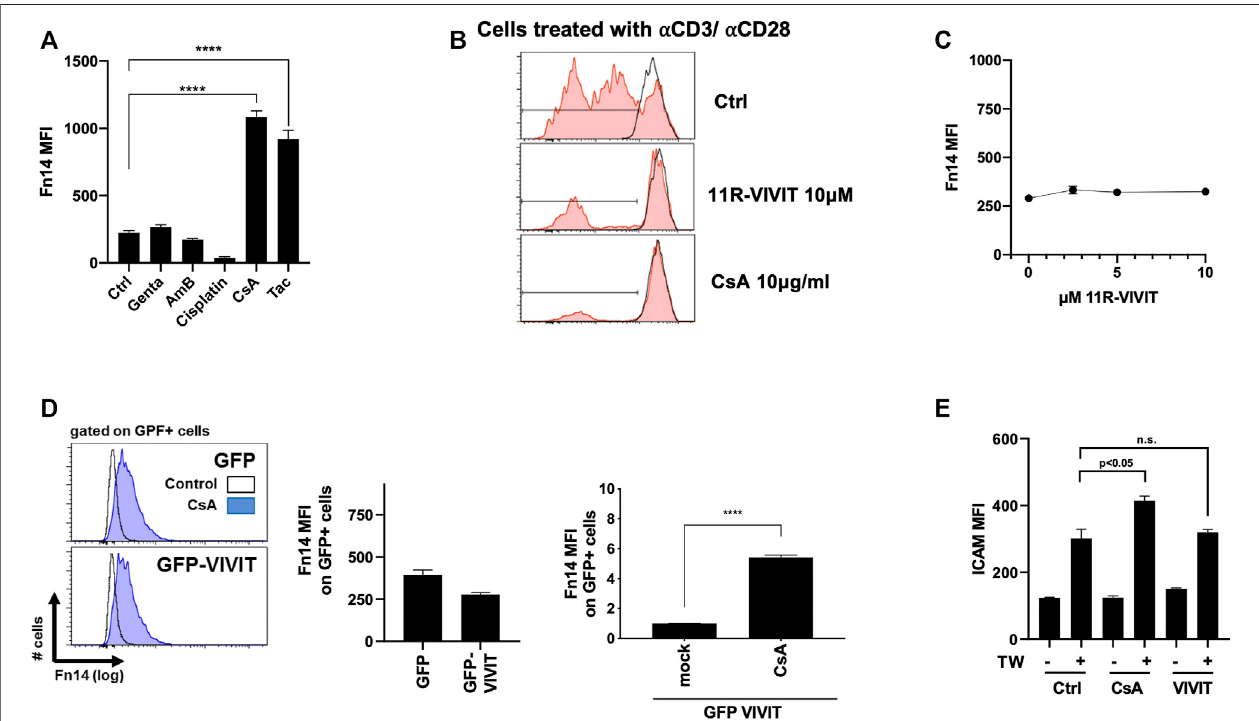
FIGURE1| Fn14inductionuponCsAexposurebutnotuponNFATinhibition. (A) Fn14inductionwithCsAandTac(CNIs)butnotwithgentamicin,amphotericinB, andcisplatin(MCT). (B) NFATandCsAsuccessfullyinhibitproliferationofTCRab-stimulatedTcells exvivo . (C-D) InhibitionoftheNFATaxis,byplasmidchemically(11R- VIVIT) or (GFP VIVIT), shows no upregulation of Fn14 on the cell surface (C: MCT, D: HEK293T). (E) Cells sensitized with CsA show upregulation of ICAM upon TWEAK treatment. Inhibition of NFAT combined with TWEAK treatment shows reduced ICAM expression, comparable to control conditions (MCT). For all fi gures, fl ow cytometry was